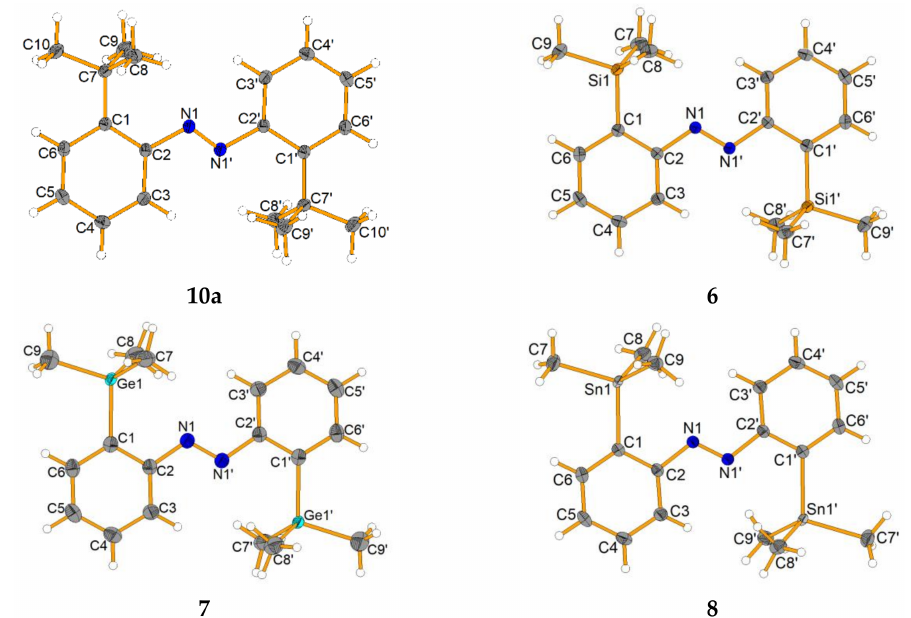
Figure 2. Molecular structures of molecules 10a , 6 , 7 and 8 , showing a 50% probability of ellipsoids. 10 crystalizes with two molecules in the asymmetric unit, only one is shown ( 10a ). The Sn-atom of 8 is disordered over two positions with occupancies of 90% and 10%, respectively. For reasons of clarity only the major component is